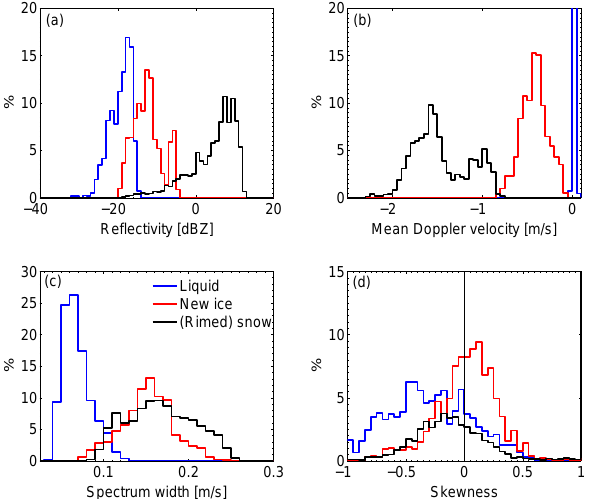
Figure 8. Probability density functions (PDFs) of noise-separated peaks of SLW (blue), ice generated in the SLW layer (red), and frontal snow (black) for the slanted paths encompassed by the two dashed lines in Fig. 4. Only data from surface to below top of the SLW layer (3.4km) are considered. Please note that the PDF of SLW V d is cut at 20%.